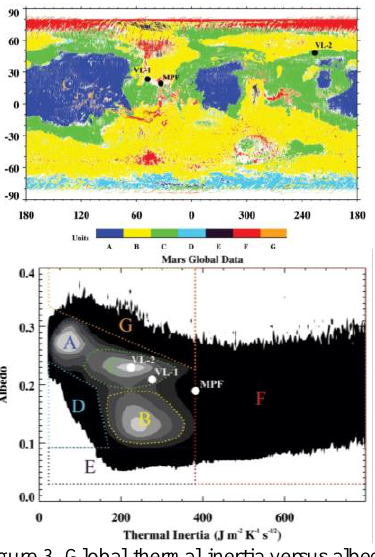
Figure 3. Global thermal inertia versus albedo (Golombek, et al.,